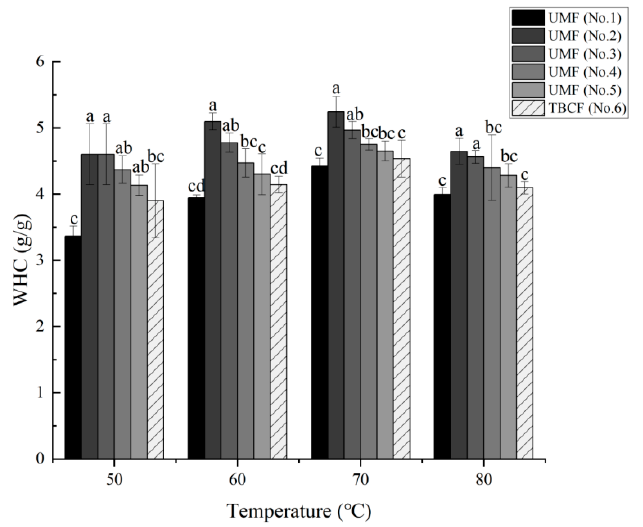
Figure 3. Effects of airflow ultrafine-grinding on the water holding capacity in Tartary buckwheat flour. The values represented by the different letters are significantly different at p < 0.05 compared with each other among the same temperature.